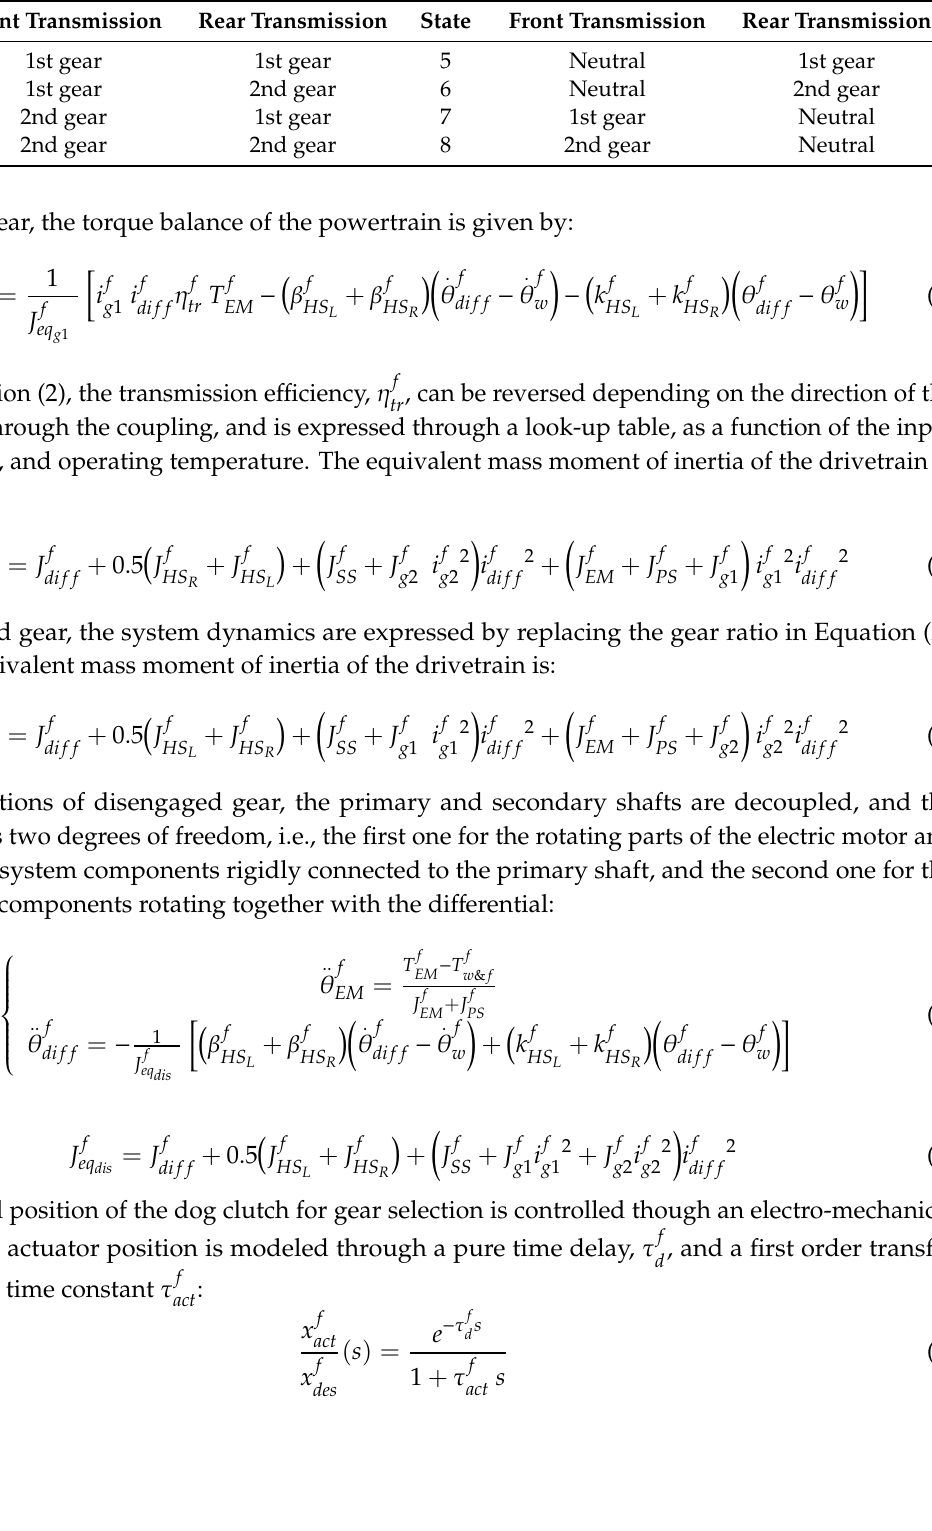
Table 2. Available gear state combinations for the 2-speed 4WD EV